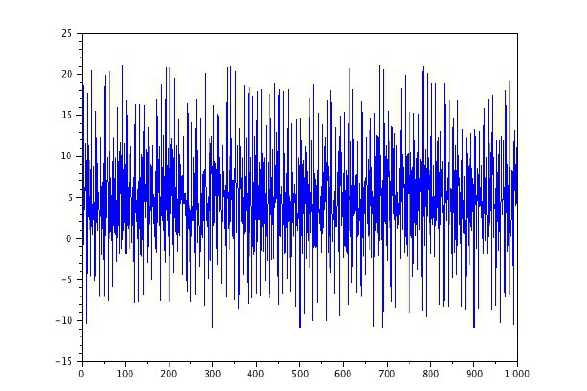
Fig. 1: a signal composed with four pure sines and white noise. amplitude signal spread over the whole range of the horizontal axis. This kind of noise is called white in the sense that the energy in this noise signal is equally distributed on the whole range of frequencies. Now, the practical applications become